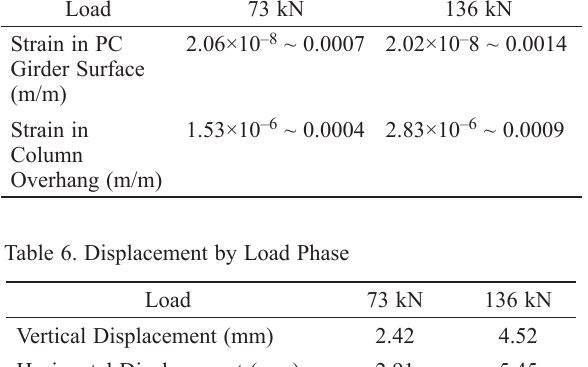
5.45 mm, respectively. The results of the analysis at less than 73 kN revealed that the maximum vertical displace- ment was 2.42 mm , and the maximum horizontal dis -